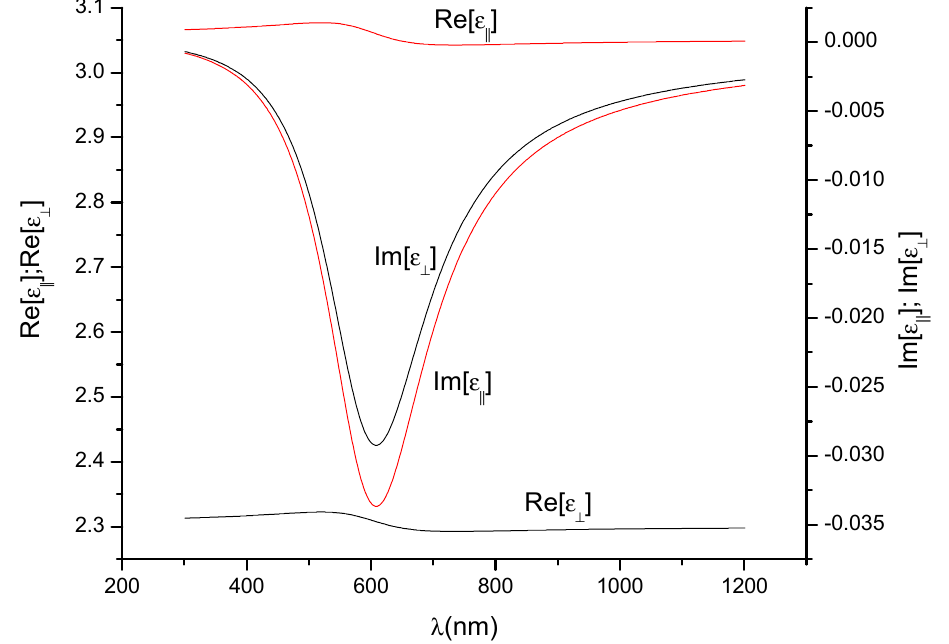
Figure 2. Spectral dependencies of the principal components of the complex permittivity tensor used for simulation of the lasing effect.